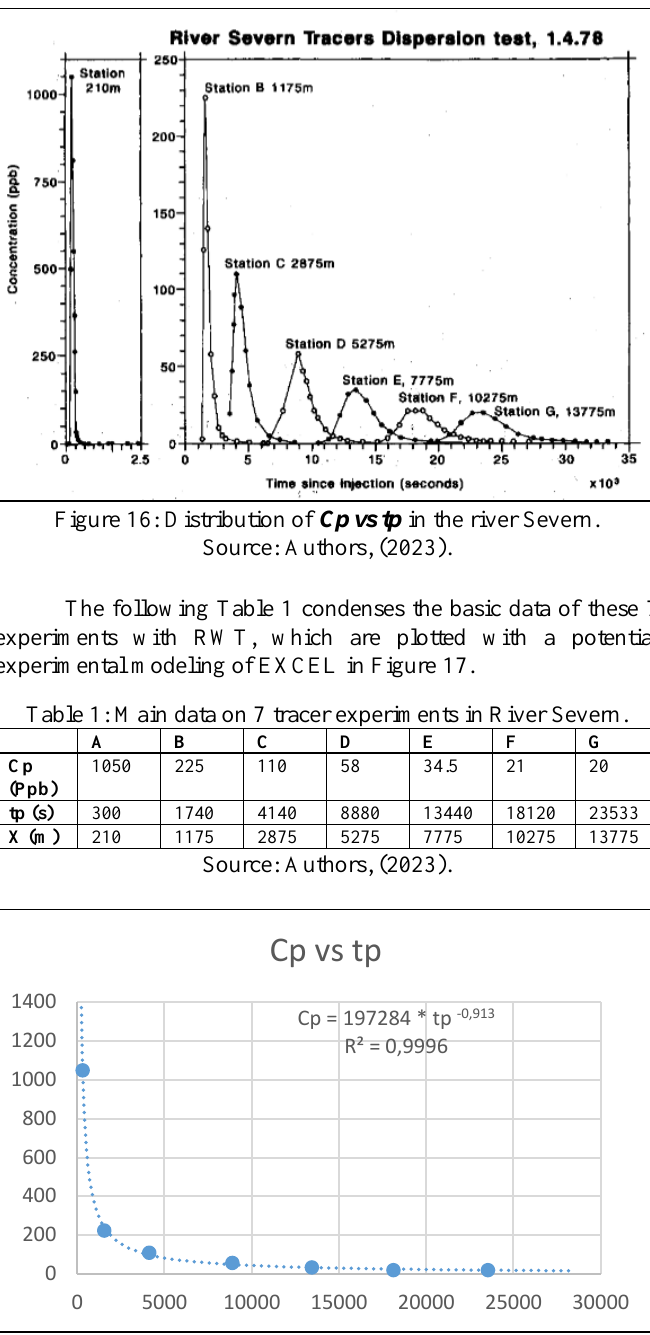
Figure 17: Cp vs tp , Severn River, with 1kg RWT injection. Source: Authors,